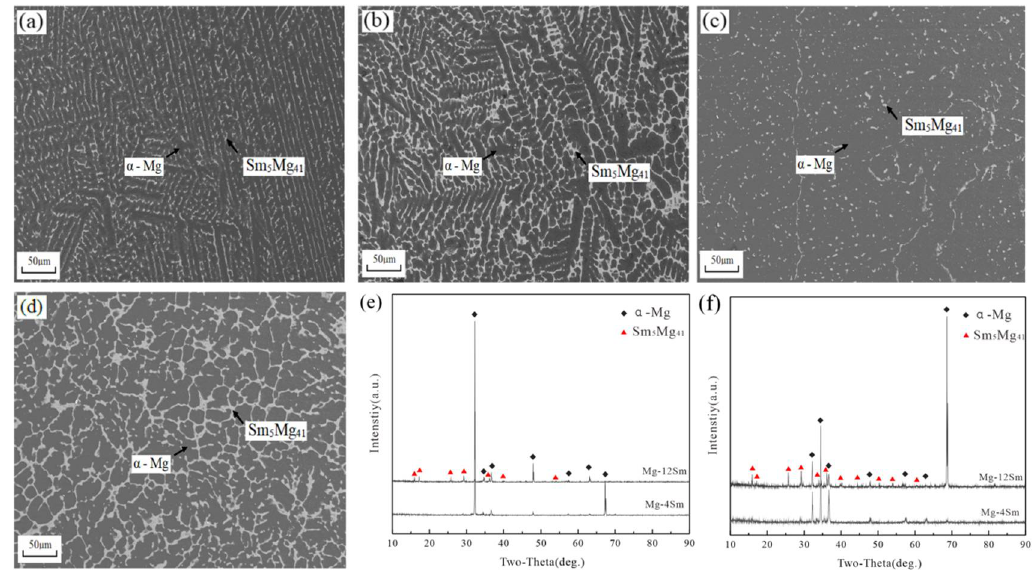
Figure 8. BSE micrographs of ( a ) the as-cast Mg-4Sm alloy, ( b ) the as-cast Mg-12Sm alloy, ( c ) the annealed Mg-4Sm alloy, and ( d ) the annealed Mg-12Sm alloy; and XRD diffraction patterns of ( e ) the as-cast Mg-4Sm and Mg-12Sm alloys, and ( f ) the annealed Mg-4Sm and Mg-12Sm alloys.